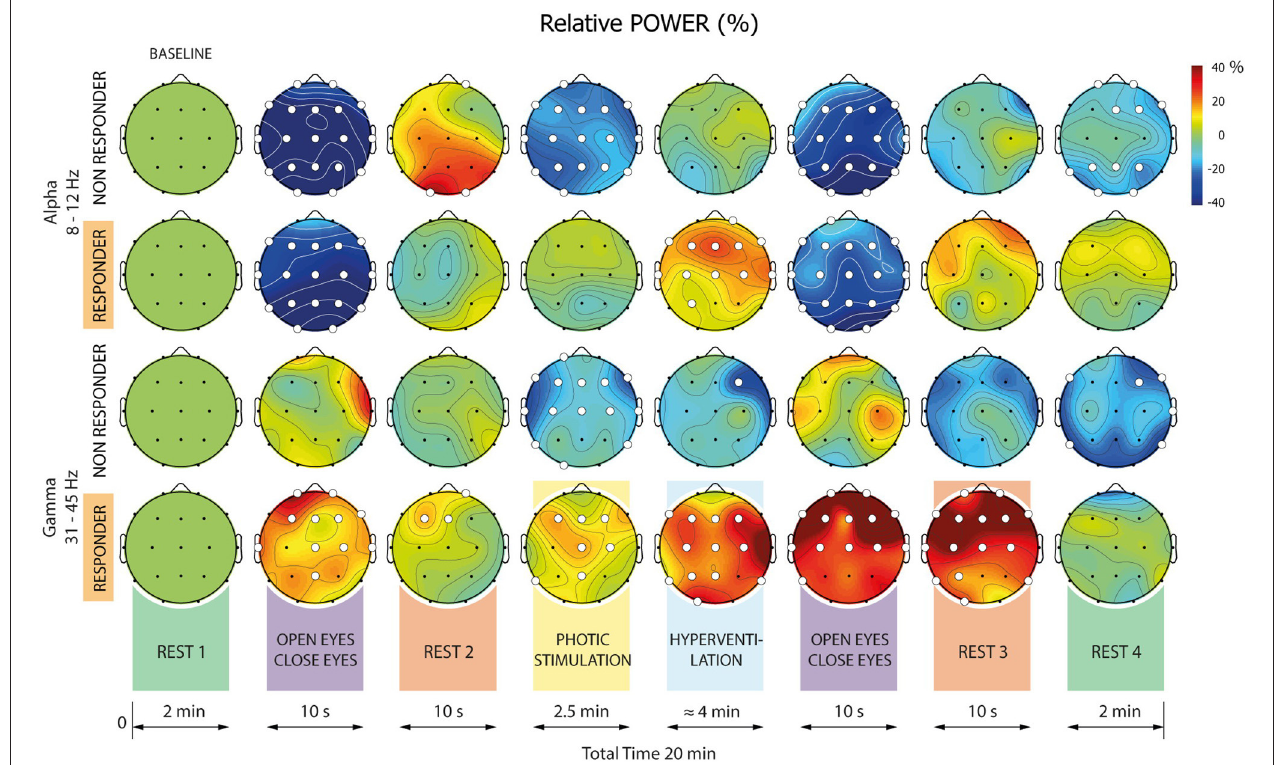
FIGURE 3 | Relative mean powers (RPWs) for all frequency bands. Each head represents RPW in a given condition and frequency band. The RPW percentage scale is displayed on the right-hand side. Where a statistically significant difference exists in a given condition relative to baseline (Rest#1), the electrode is marked by a white dot. If no significant difference exists, the electrode is marked by a black